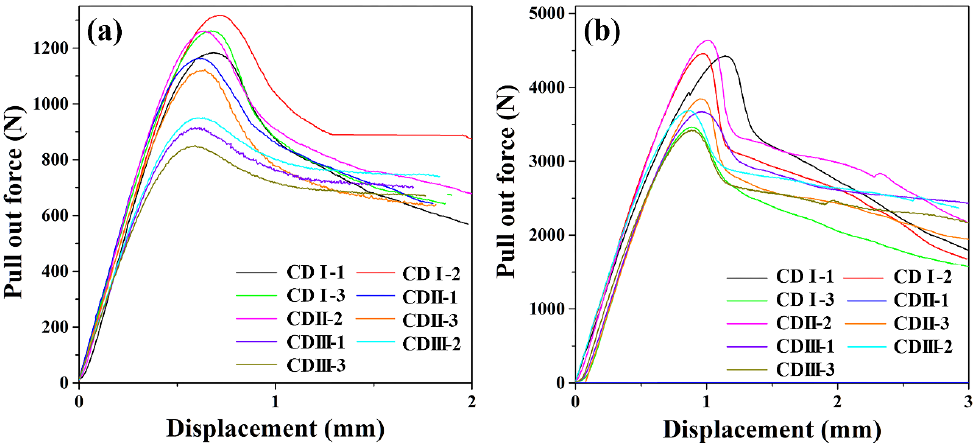
Figure 3. ( a ) Pedicle screw 3D model, ( b ) products, ( c ) parameters of pedicle screw and ( d ) schematic diagram of pullout test.